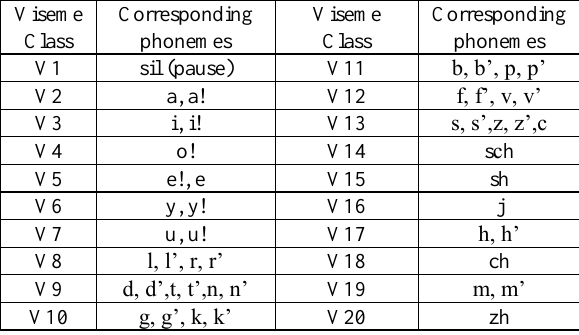
Table 2. Viseme classes and phoneme-to-viseme